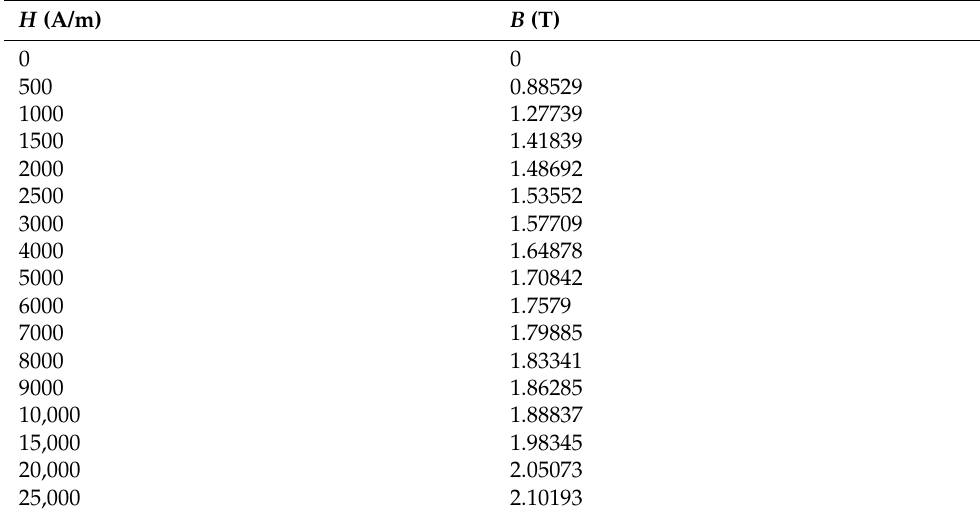
Figure 3. Simulation model for the mechanism of LMF enhancement. Table 1. The B - H curve of carbon steel Q235 .